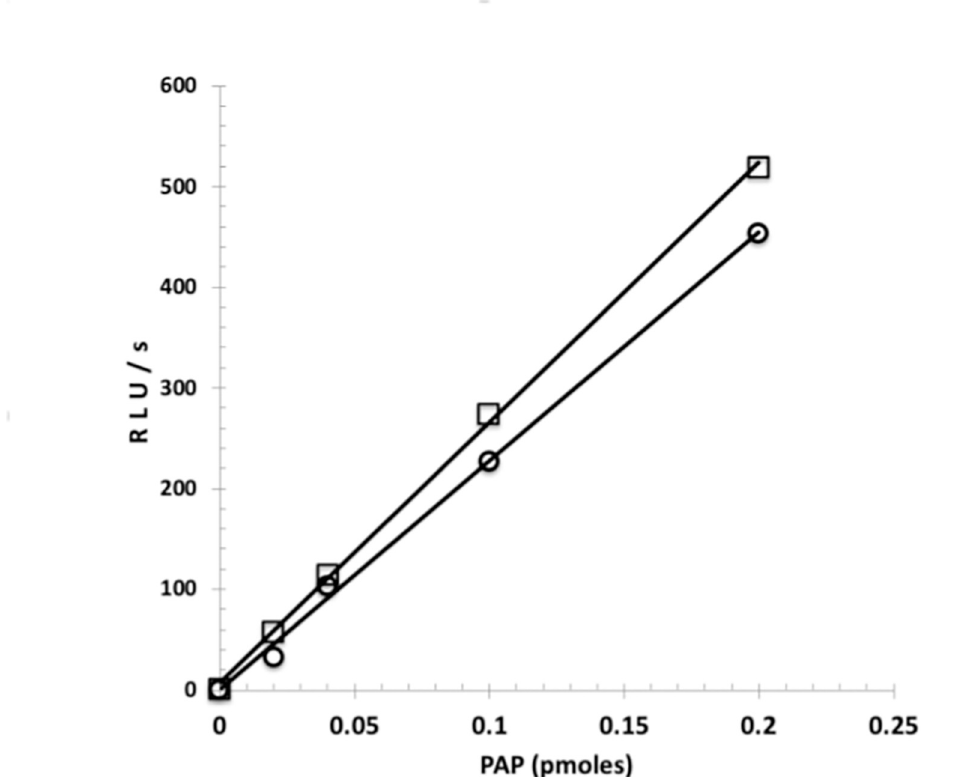
Fig 8. PAP assay. The Coelenterazine sulfotransferase Assay was performed as described in Materials and Methods. The reaction volumes were 100 μ l and the amount of PAP varied as shown. The amount of sulfotransferase was 9.5 nmoles for 3A(circles) and 4 nmoles for